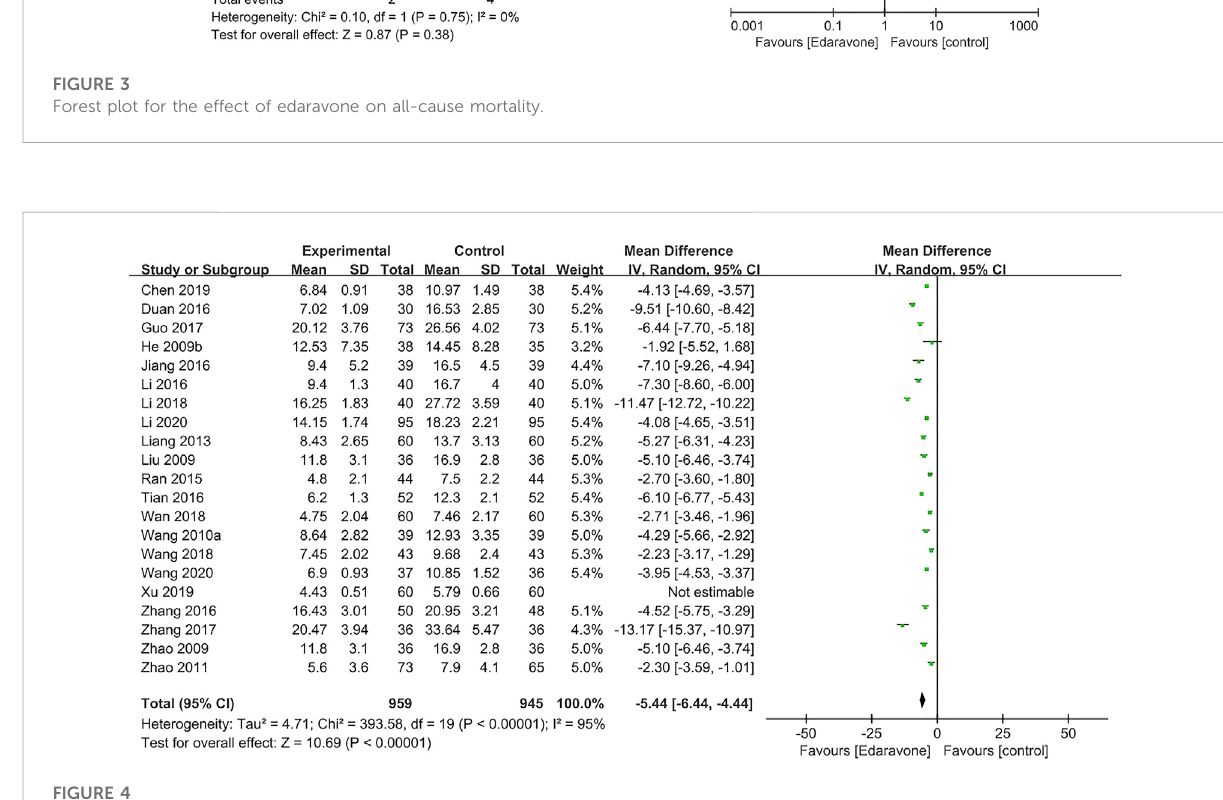
FIGURE 4 Forest plot for the effect of edaravone on the NIHSS